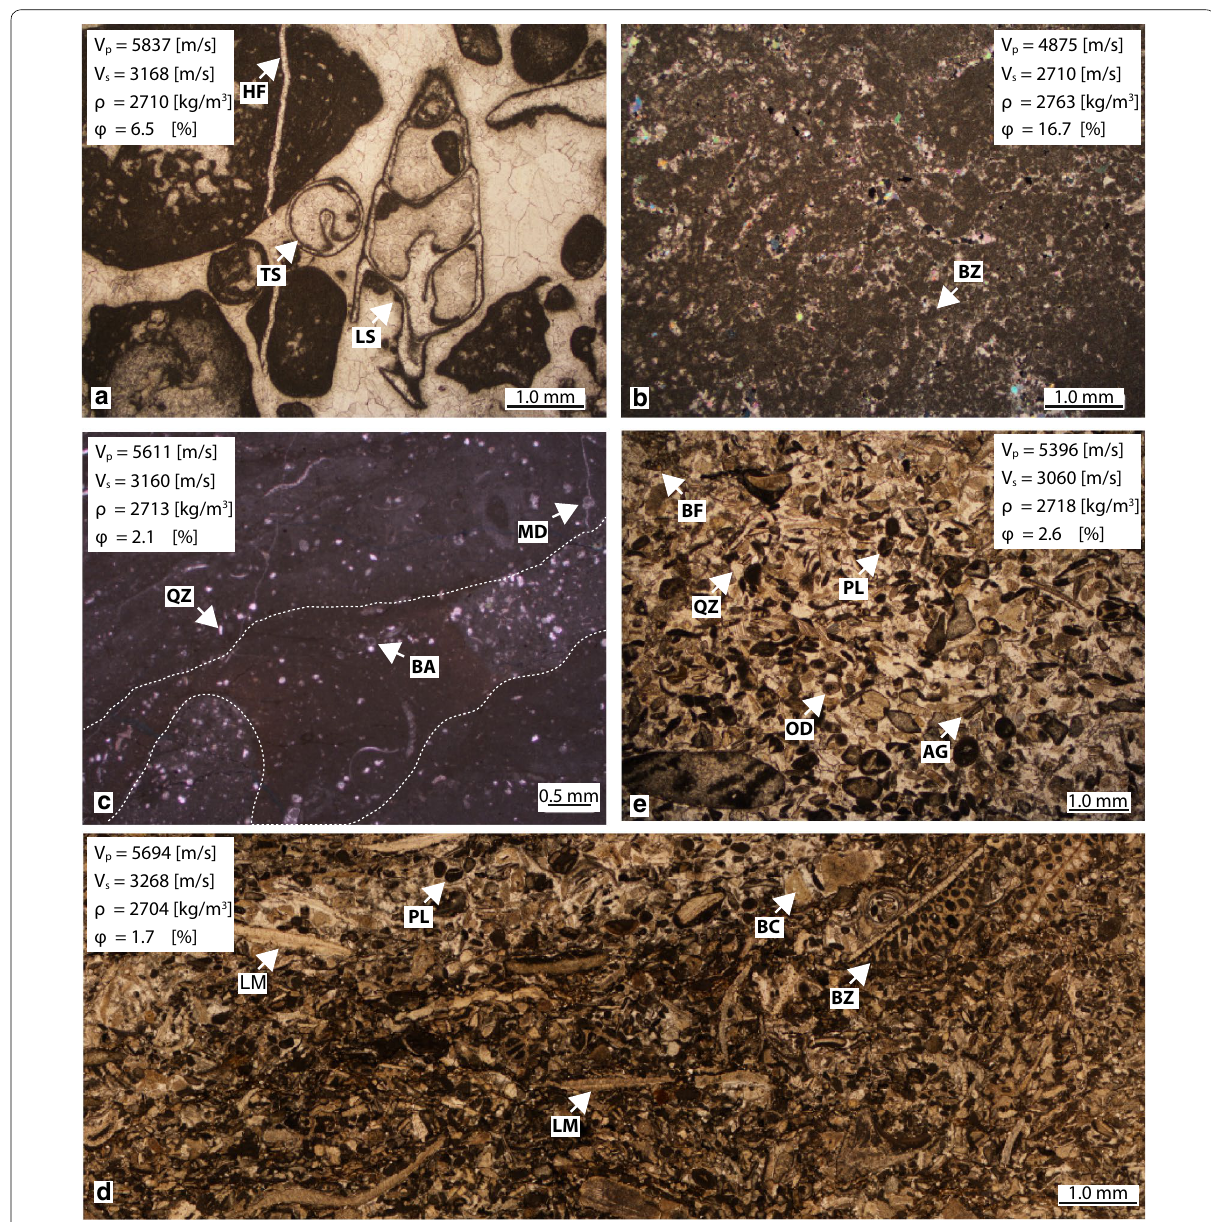
Fig. 7 Optical photomicrograph of representative samples: a and b sample HU01; Upper Jurassic Carbonate section. A wide abundance of tubiphytes (TP), bryozoans (BZ), sponge/algae reefs (SG), and mollusca debris (mainly gastropods) were observed. Well-preserved longitudinal (LS) and transversal (TS) cross-sections of a high-spired gastropod show spar-infilled chambers and internal cavities, while the external outline is micritic sediment. Fractures (HF) were filled by a sparite cement. c sample HU07; Bathonian—bioclastic Mudstone-Wackstone unit. Bioclasts, including benthonic forams such as miliolids (MD), echinoderms and bioclastic algae (BA), are embedded in a micritic or peloidal calc-mud matrix; Diagenetic or post-depositional features including the formation of horsetail stylolites due to compaction were observed. d sample HU09; Bathonian—Benthic Crinoidal Packstone unit, where Benthonic Crinoidal (BC), bryozoa (BZ), and Lamellibranchs (LM) fragments representing the most abundant component. e sample HU12; Bajocian—Peloidal Packstone-Grainstone unit, showing abundance of foraminifers bioclasts (BF), algae (AG), peloids (PL) and few ooids